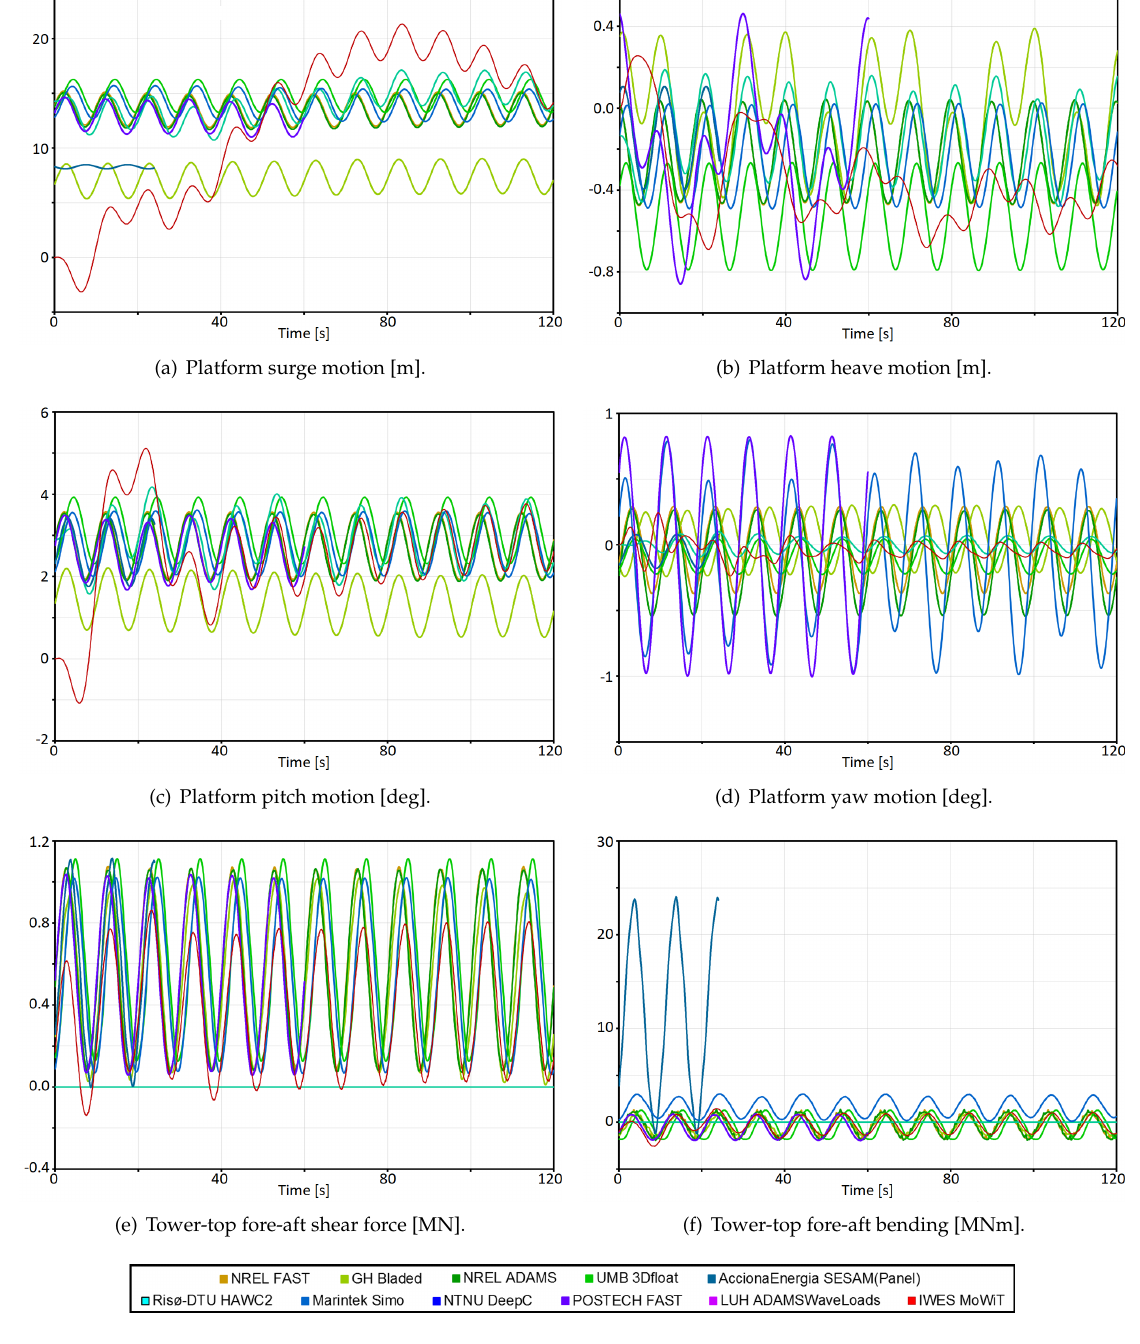
Figure 14. Aero-hydro-servo-elastic time series with regular waves from LC 5.1, part